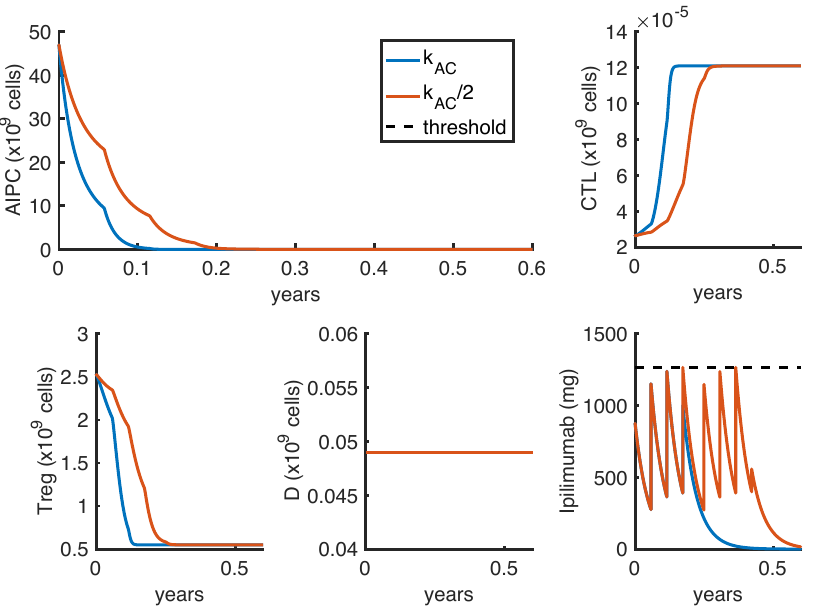
Figure A1. Comparison between administration protocols obtained with different values of the parameter k AC . The dynamics refer to the ipilimumab mono-therapy as result of the optimization problem OP2, with ∆ t = 3 weeks. Blue lines represent the model outcomes with the estimate value of k AC (the same presented in Figure 6, blue line), while orange lines represent the one with k AC . The ipilimumab threshold has been highlighted with a black dotted line. 2